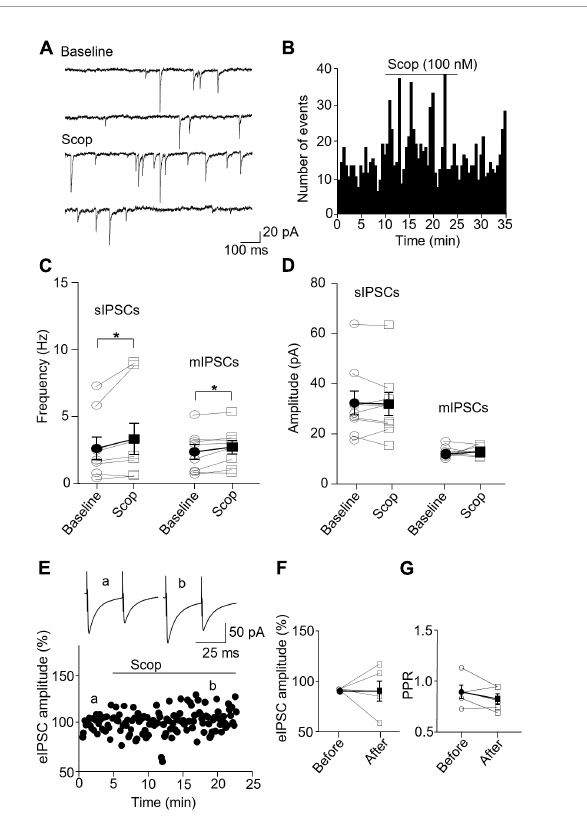
FIGURE6 Blocking mAChRs enhances inhibitory synaptic transmission in the SST interneuron. (A) Representative traces of sIPSCs from an SST interneuron before and after application of scopolamine. (B) A histogram shows the effect of scopolamine on sIPSC frequency in the SST interneuron. (C,D) Summarized data show the effect of scopolamine on sIPSC ( n = 7 cells/5 mice) and mIPSC ( n = 8 cells/5 mice) frequency and amplitude, respectively. (E) A representative experiment from an SST interneuron shows the effect of scopolamine on the amplitude of evoked IPSCs. Inserts: the traces of evoked IPSCs taken at the times indicated by a and b in the graph. (F,G) Summarized data showing the effect of scopolamine on evoked IPSC amplitude ( n = 5 cells/4 mice) and paired-pulse ratio, respectively. * p < 0.05. before and after scopolamine were 2.37 ± 0.55 and 2.72 ± 0.52 Hz,